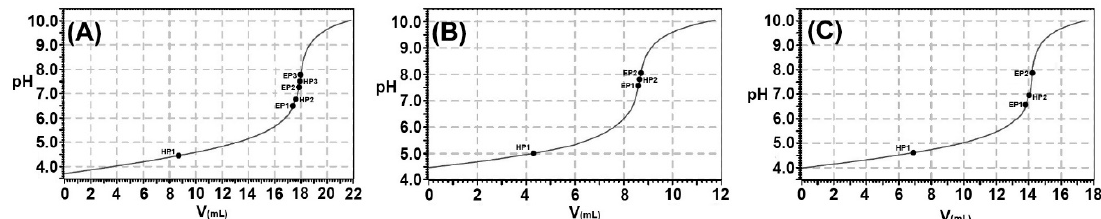
Figure 3. Automatically generated titration curves for the estimation of the pKa values (CALB-catalyzed hydrolysis). Curve ( A ) corresponds to the titration of erythritol tetrapalmitate (three pKa = {4.45, 6.77, and 7.51}), curve ( B ) corresponds to the titration of erythritol tetralaurate (two pKa = {5.01 and 7.82), and curve ( C ) corresponds to the titration of pentaerythritol tetrapalmitate (two pKa = {4.61, 6.95}).